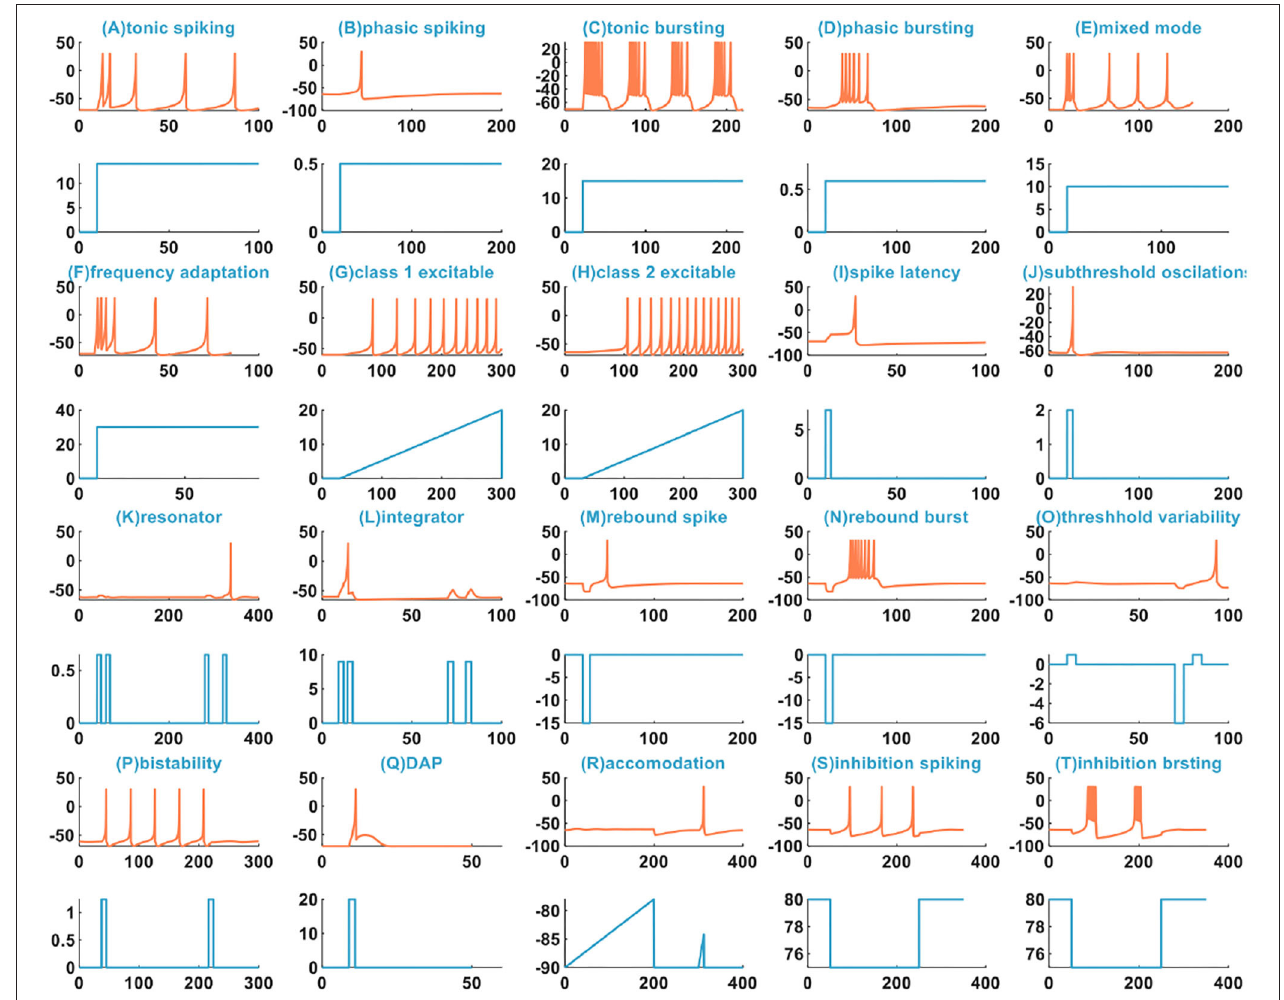
FIGURE 1 | The 20 spiking patterns are generated by the IZH spiking model [x-coordinate is the time ( ms ), y-coordinate is the membrane potential ( mV ) in the plane with the coral color curve. x-coordinate is the time ( ms ), and y-coordinate is the external stimulus current ( pA ) in the plane with the light blue